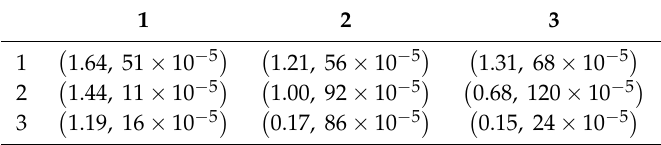
Table 2. Optimal θ parameters for U αβ = 0.035 (A), U sw = 5500